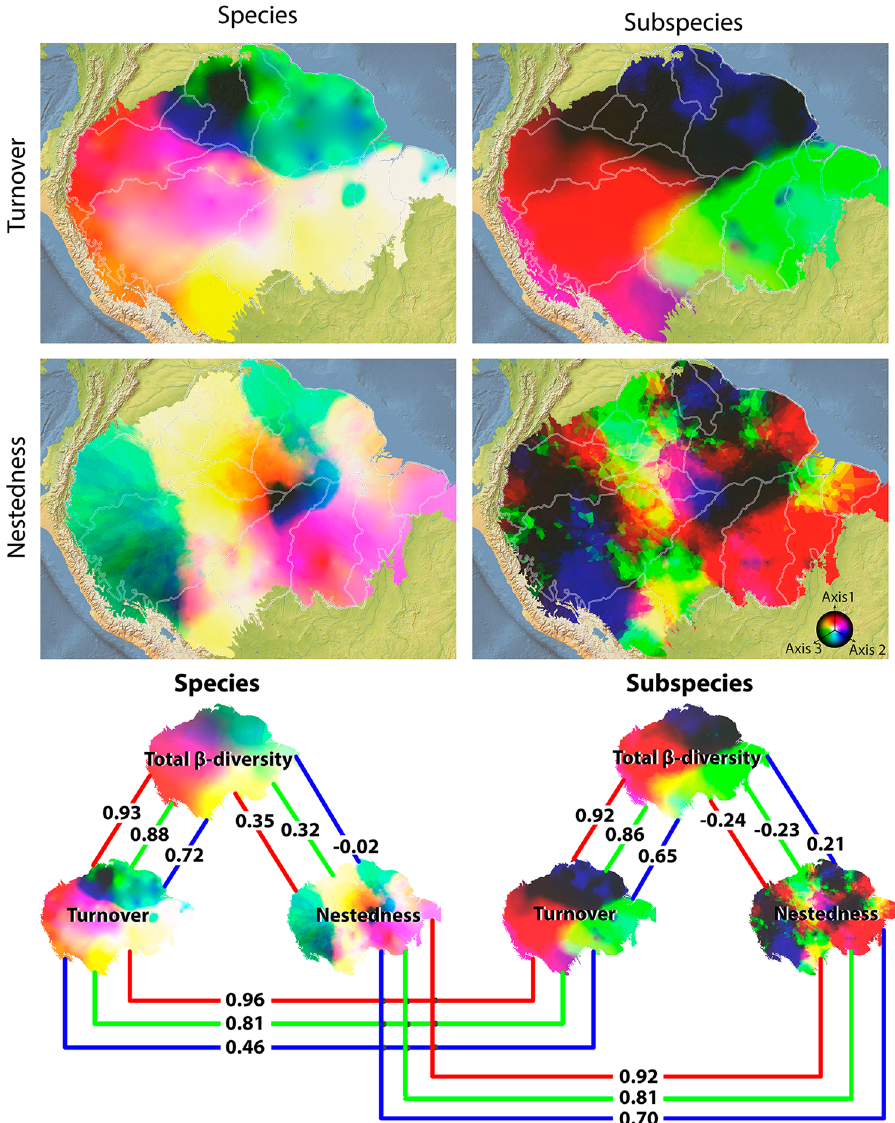
Figure 4. Partitions of spatial variation of bird species composition throughout the Amazon. Species composition was obtained by interpolation of NMDS scores (three axis represented by a RGB scale). Beta- diversity is partitioned into turnover and nestedness for species and subspecies. Lines indicate each axis and correlation between them. Maps created in ArcGIS 10 . 1